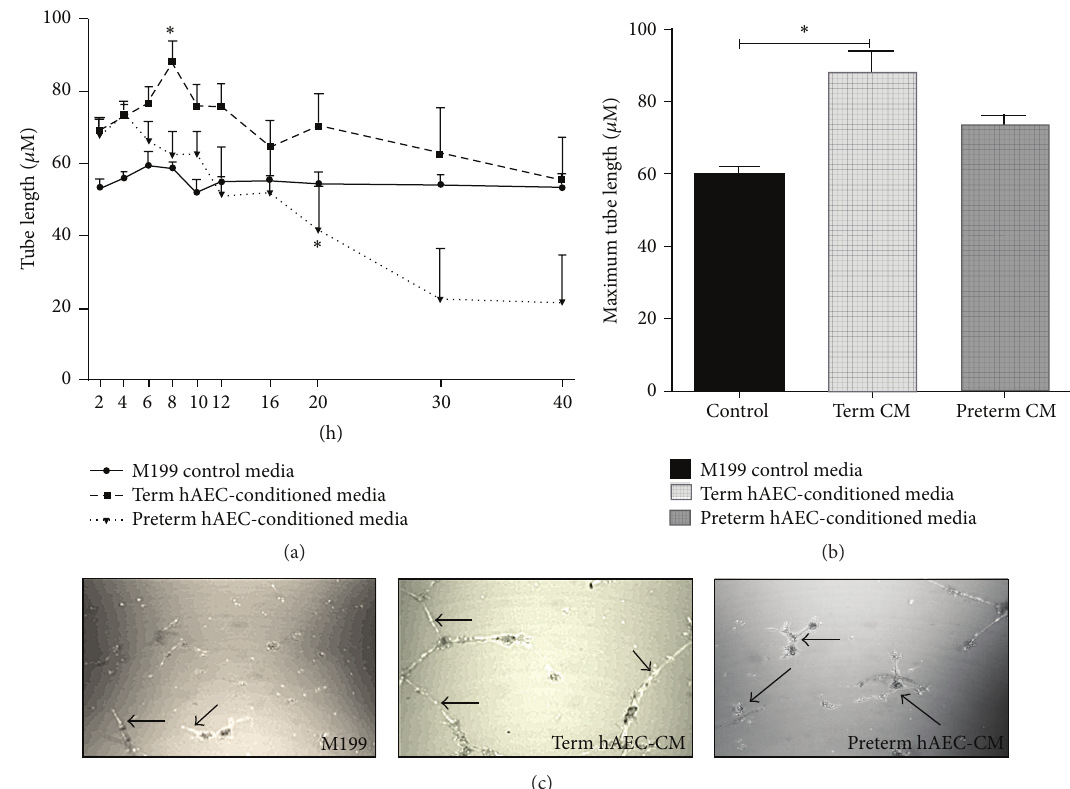
Figure 1: The vascular tube formation in huVECs on Matrigel in vitro . ((a) and (b)) huVECs formed longer vascular tubules following culture in term hAEC-conditioned media compared to control media ( 𝑝 < 0.05 ), and tubule lengths were stable for 40 hours. huVECs cultured in preterm hAEC-conditioned media did not support tubule formation where tubule length was significantly reduced at 20 hours ( 𝑝 < 0.05 ). (c) Representative pictures of vascular tubules of huVECs following culture in term hAEC-conditioned media and control media ( ∗ 𝑝 < 0.05